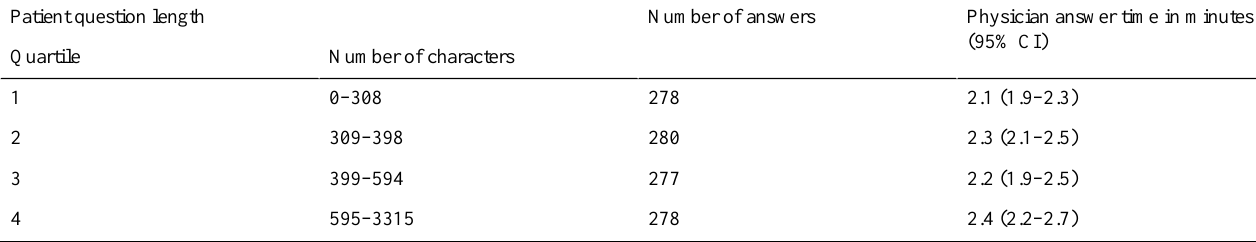
Table 4. Time physicians spent answering patients’questions by question